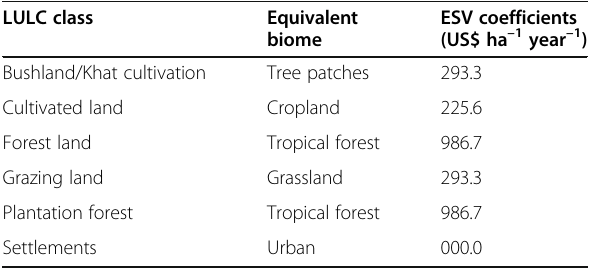
Table 1 Biome equivalents for land-use/land-cover (LULC) classes and the corresponding ecosystem service value (ESV) coefficients based on the modified estimates of Kindu et al.